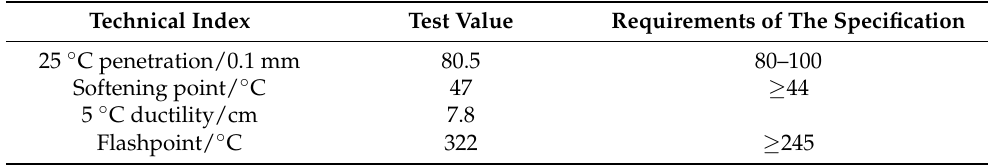
Table 1. Basic physical properties of base